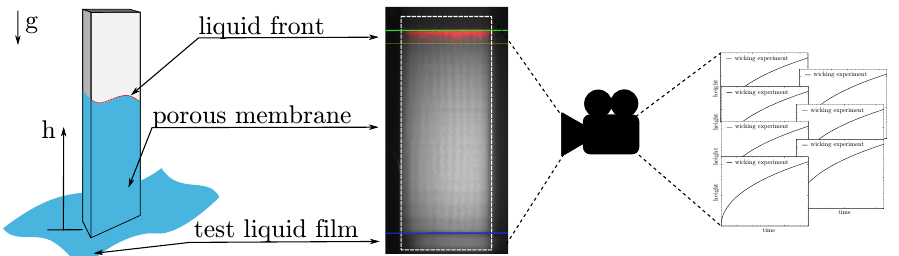
Figure 4. Schematic description of the wicking experiment ( left ) and a real image of the detection of the liquid front, taking place during the experiment ( right